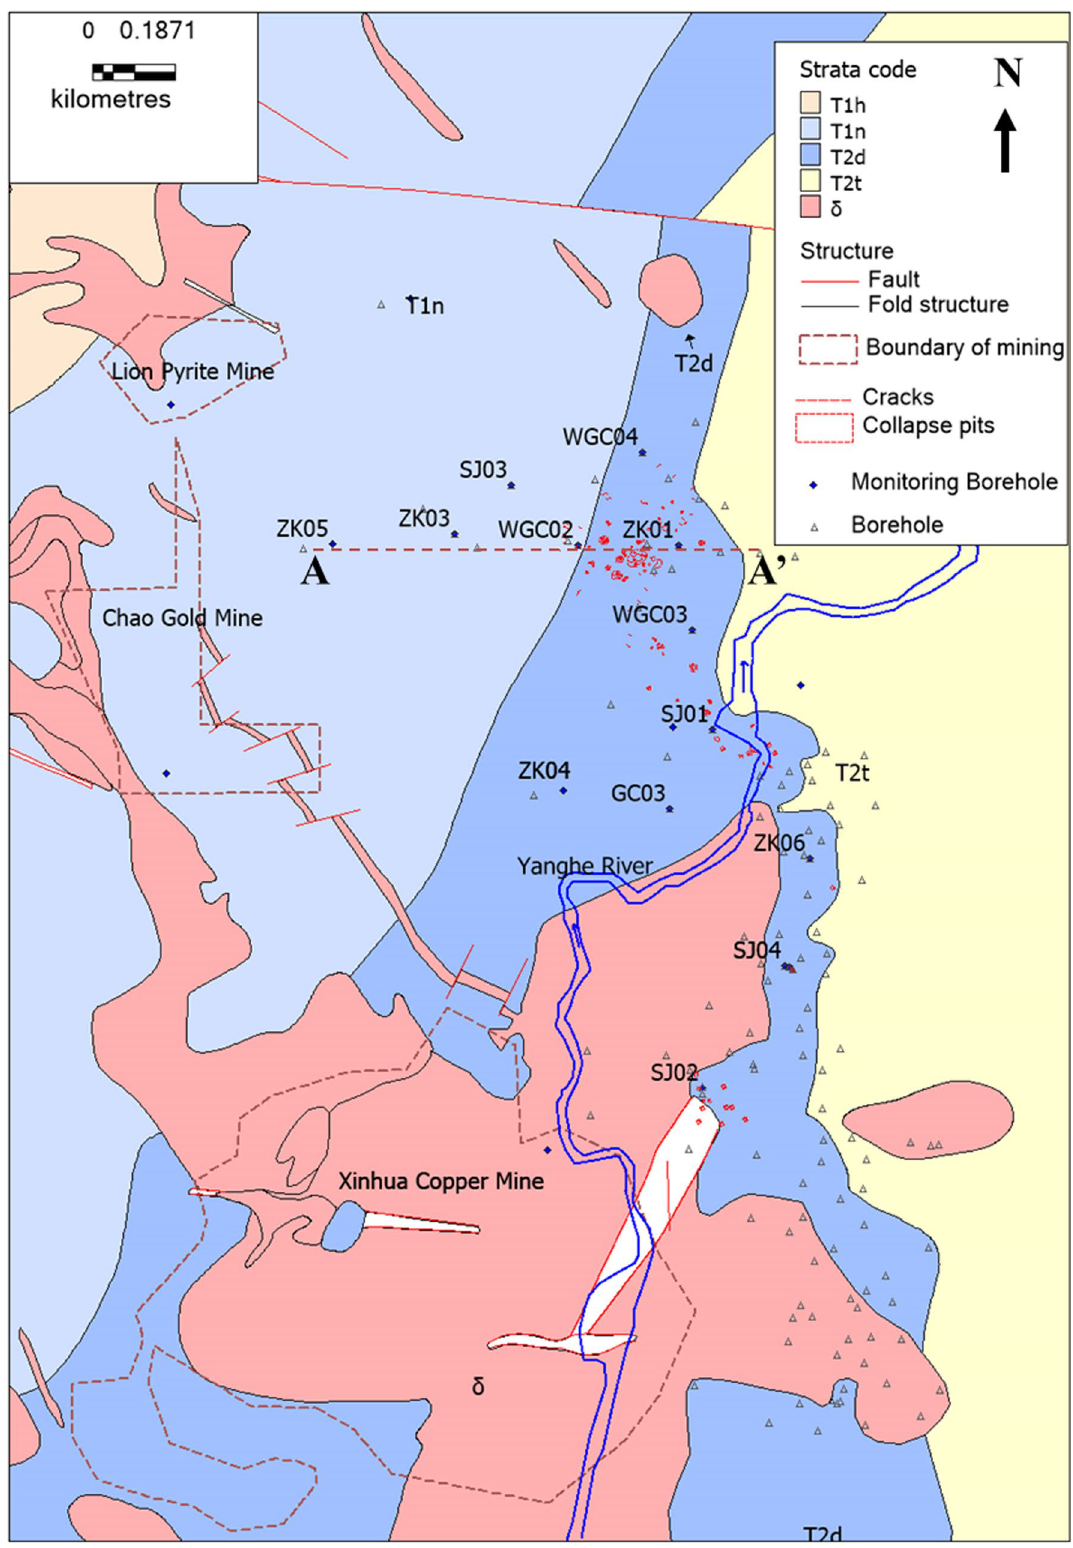
Fig. 2 Distribution of karst groundwater-air monitoring wells (see Table 1 for legend of